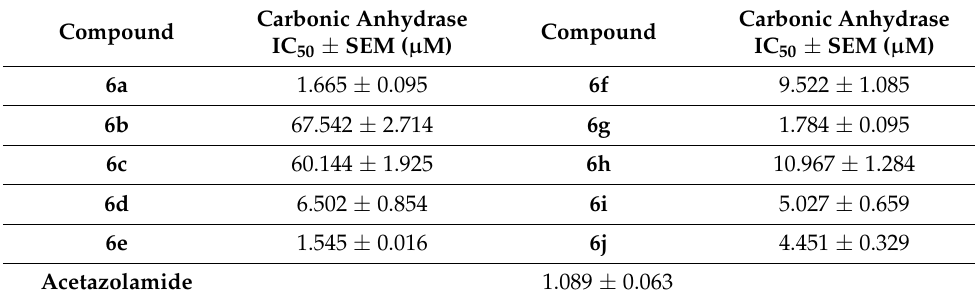
Table 1. In vitro inhibiting potential of synthesized derivatives against CA-II.